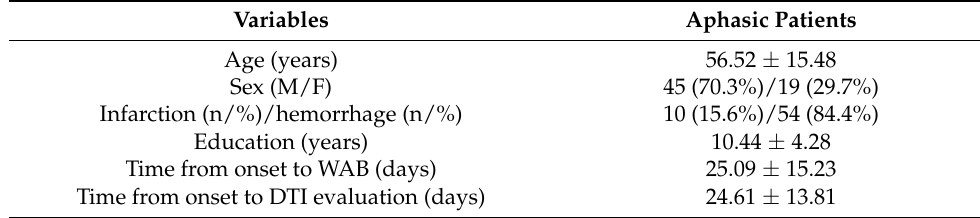
Abbreviations: DTI, diffusion tensor imaging; WAB, Western Aphasia